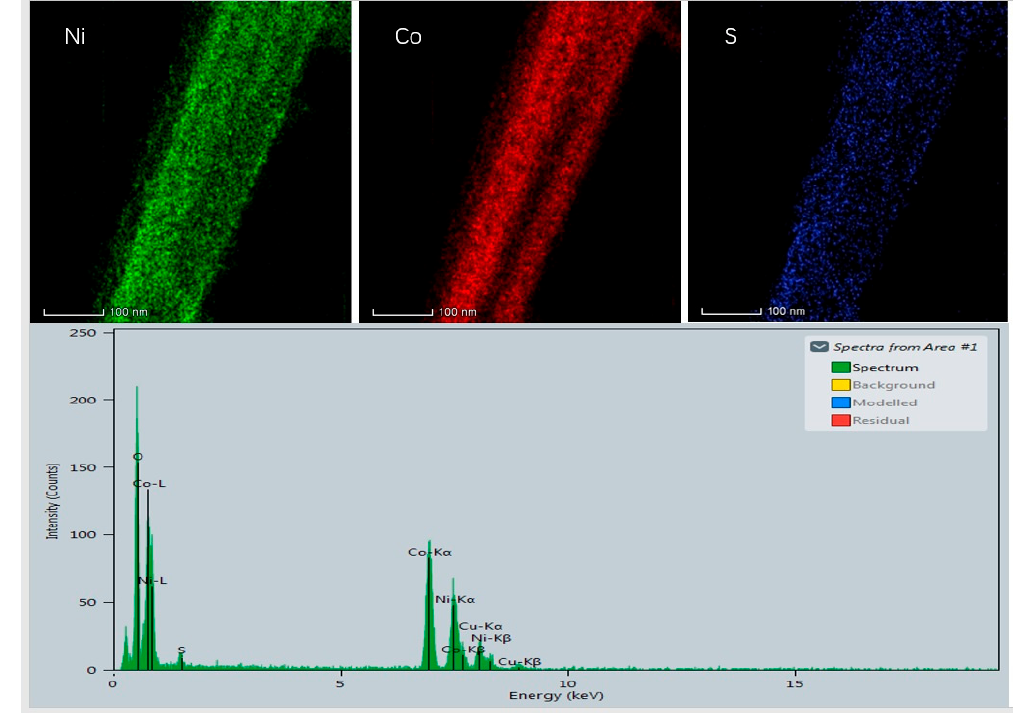
Figure 5. ( a ) TEM and ( b ) HRTEM images of individual NiCo2O4@NiCo2O4 hierarchical nanostructures and (c) inset showing the SAED.